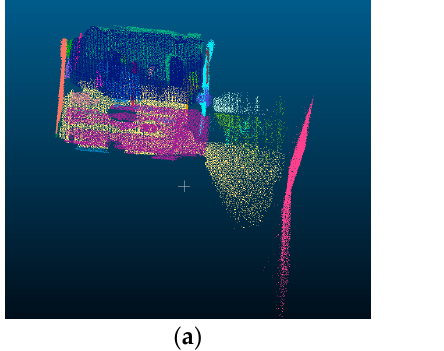
Figure 14. Room Segmentation Process in Scenario 2. Trajectory points in blue, detected doors in red.